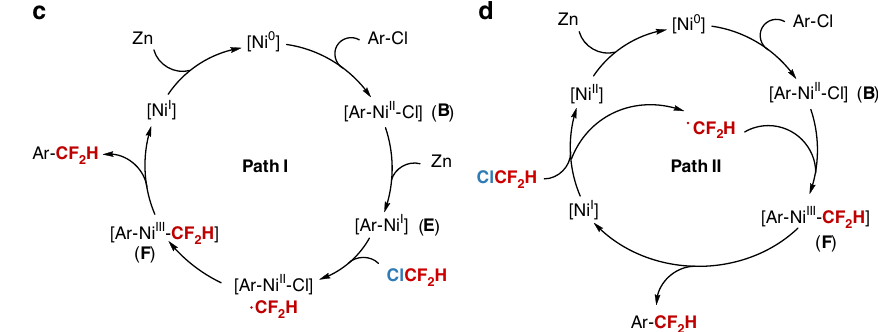
Fig. 6 Proposed reaction mechanism. a Proposed mechanism via a radical-cage-rebound process. b Proposed mechanism via a radical chain